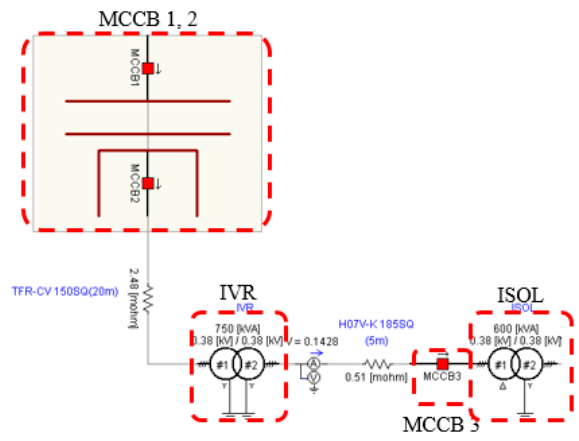
Figure 7. Modeling of distribution panel section.